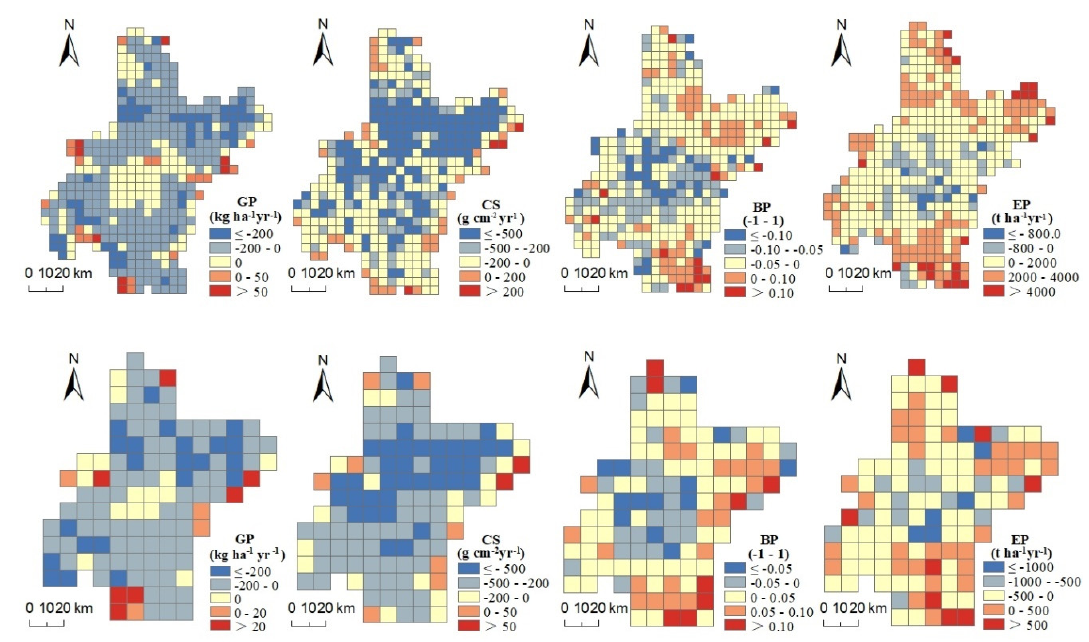
Figure 3. Maps of ecosystem services changes during 2005–2015 at 5 km ( upper row ) and 10 km ( lower row ) grid scales. Abbreviations: Grain productivity (GP); Carbon sequestration (CS); Biodiversity potential (BP); Erosion prevention (EP). Table 1. Globally spatial autocorrelations of ecosystem services changes at two grid scales during 2005–2015. 5 km Grid Level 10 km Grid Level ESs Moran’s I p -Value